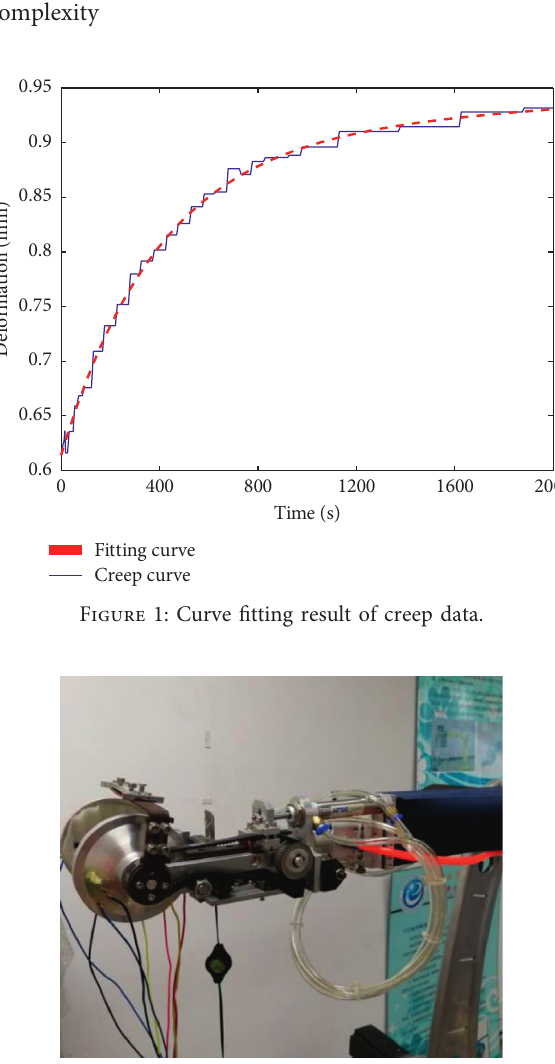
Figure 2: End-effector of apple harvesting robot.